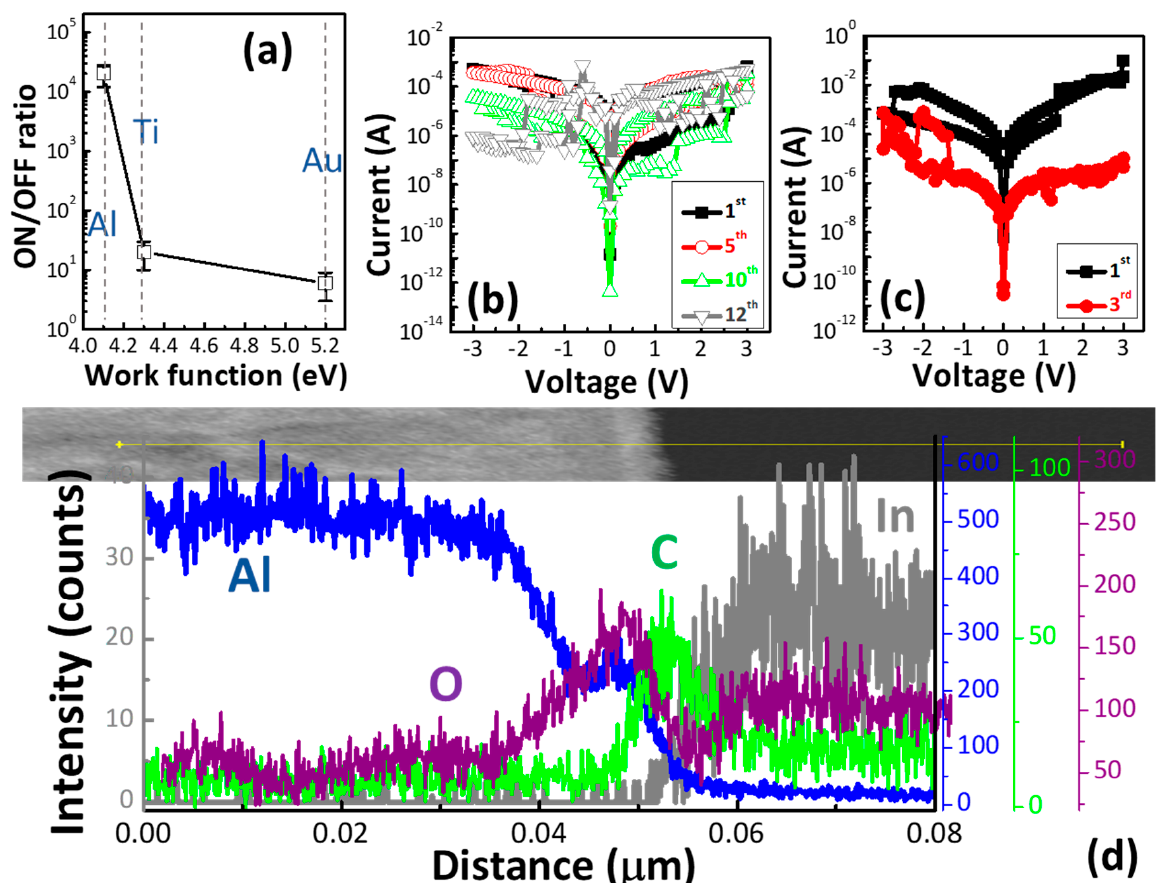
Figure 4. ( a ) The ON/OFF ratio of the C1 memory devices with various top electrodes. The switching cycles of the ( b ) Ti/C1/ITO and ( c ) Au/C1/ITO structures. ( d ) The line-scan profiles along the yellow line marked in the TEM image of the C1 memory device.